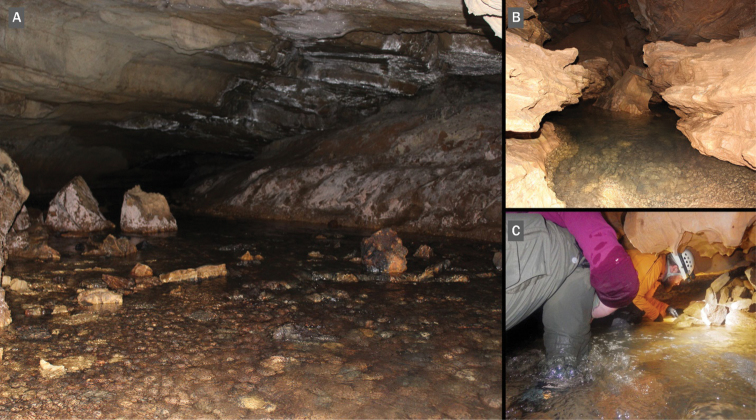
A Cave Creek Cave. Bottom B Pedigo Cave C Eblen Cave (NSG and ETC). Photograph credits: A, B NSG C EBP.